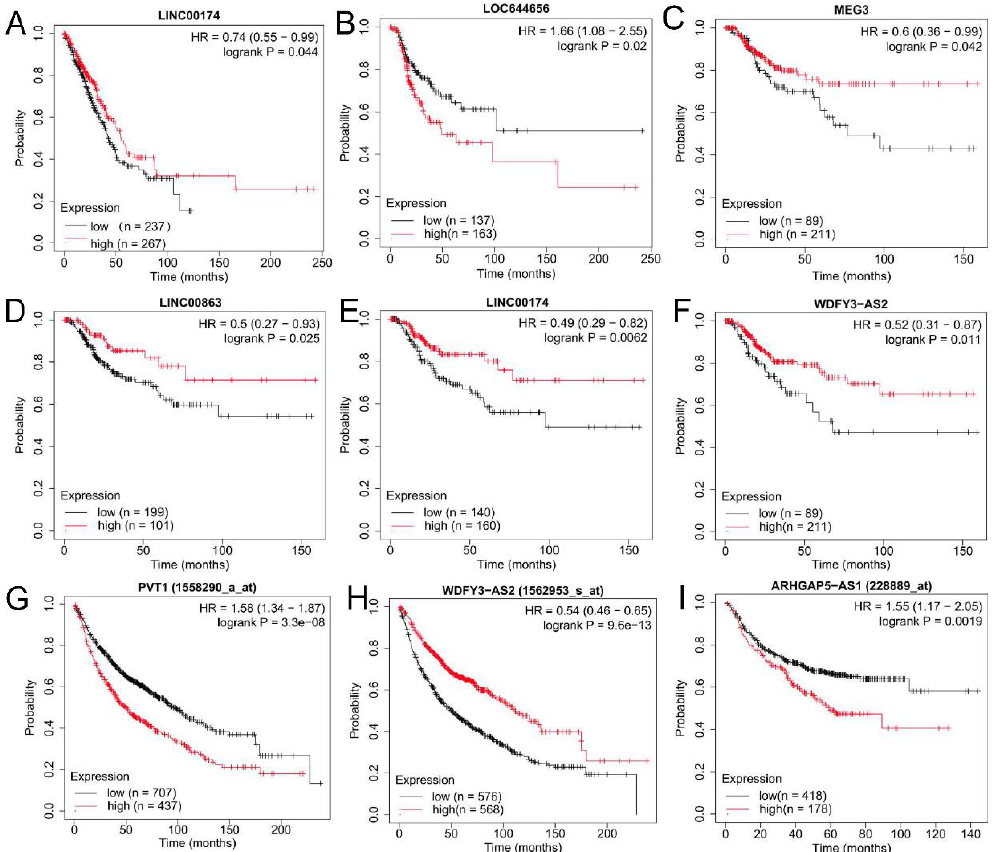
Figure 5. Validation of the prognosis of lncRNAs in lung cancer. ( A ) LINC00174. Prediction for overall survival of LUAD patients by analysis of TCGA data; ( B ) LOC644656. Prediction for recurrence-free survival of LUAD patients by analysis of TCGA data; ( C – F ) MEG3 ( C ), LINC00863 ( D ), LINC00174 ( E ) and WDFY3-AS2 ( F ). Prediction for recurrence-free survival of LUSC patients by analysis of TCGA data; ( G,H ) PVT1 ( G ) and WDFY3-AS2 ( H ). Prediction for overall survival of all lung cancer patients by analysis of chip data; ( I ) ARHGAP5-AS1. Prediction for first-progression survival of all lung cancer patients by analysis of chip data. HR, hazard ratio; LUAD, lung adenocarcinoma; LUSC, lung squamous cell carcinoma; TCGA, the Cancer Genome Atlas.